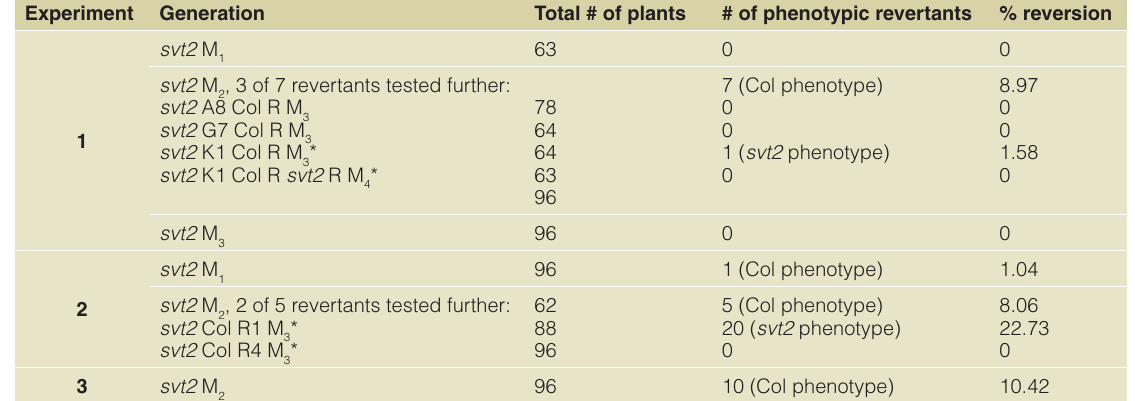
Figure 7. Insertion/Deletion polymorphism analysis in svt2 , Col-0 and L er -0. Primers were designed for five randomly selected InDel polymorphisms across the five Arabidopsis chromosomes. The polymorphisms represent insertions in Col-0 and deletions in L er . Table 3. Summary of revertant data. The table summarizes the number of plants screened in each of three svt2 generations (M , M and M ), screens of revertant progeny from Col-like revertants (A8, G7, K1), and the revertant progeny of a L er -like 1 2 3 line (K1 Col R svt2 R). The percent reversion is shown in the last column. Although the number of progeny plants tested is relatively large, some lines did not give rise to revertant progeny. R denotes revertant. *indicates mutant plants that were also analyzed genotypically (see Table